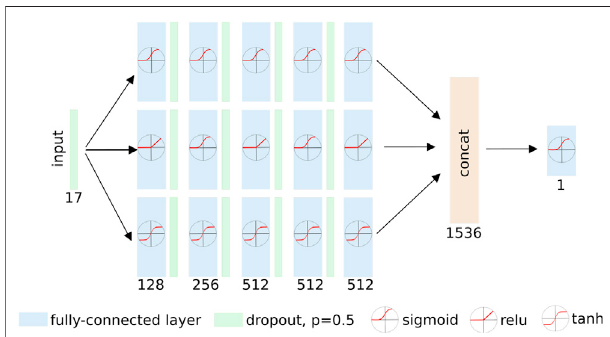
FIGURE 2 | Af fi nity prediction model. The model consists of three separate paths from input to output, each composed of fi ve sequential fully- connected layers. Each path uses a separate set of activation functions, allowing the network to learn diverse representations of the input. The outputs of the three paths are concatenated and passed through a fi nal fully- connected (FC) layer that emits a prediction of binding or non-binding. Fully- connected(FC)layers arerepresentedwithblue blocks. Thenumber ofnodes in each FC layer is indicated below the block. Activation functions applied to the output of the FC layers are shown in circles. The model was trained for 2000 epochs and batch size 8,192 with the Adam (Diederik and Ba, 2014) optimizer using default β 1,2 parameters and a learning rate of 0.001. Dropout (Srivastava et al., 2014) with p = 0.5 was applied after each fully connected layer during training, and also during